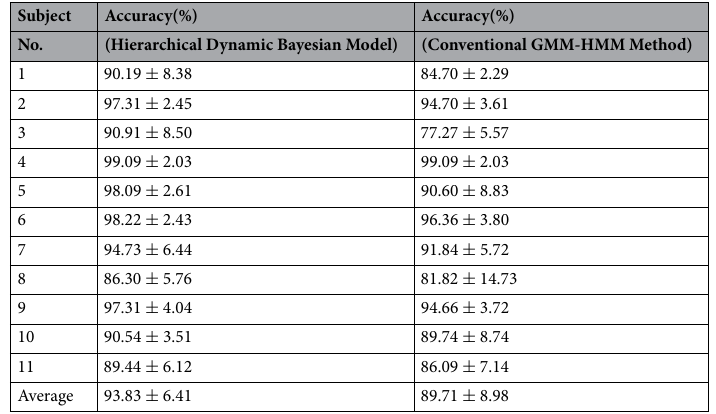
Table 4. Prediction accuracy of hierarchical dynamic Bayesian model and conventional GMM-HMM. standard deviation . Average accuracy rates are tested for statistical significance Accuracy is reported as mean ± by Wilcoxon signed-rank test on the accuracy being higher with the hierarchical dynamic Bayesian model than 0.0021 < 0.01 with the conventional method. ( p =